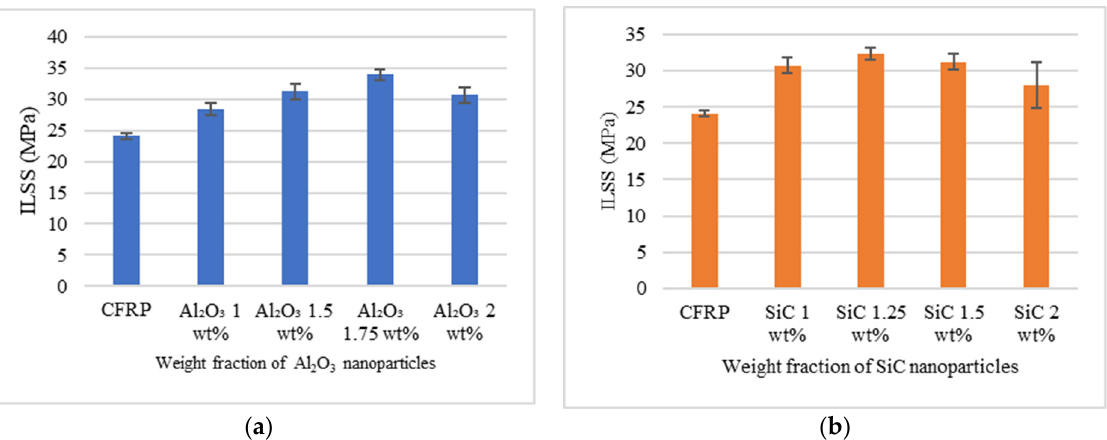
Figure 11. Interlaminar shear strength of neat and ( a ) hybrid Al 2 O 3 and ( b ) hybrid SiC nanocomposites at various weight fractions. Table 8. Interlaminar shear strength of neat and hybrid Al 2 O 3 nanocomposites. Material